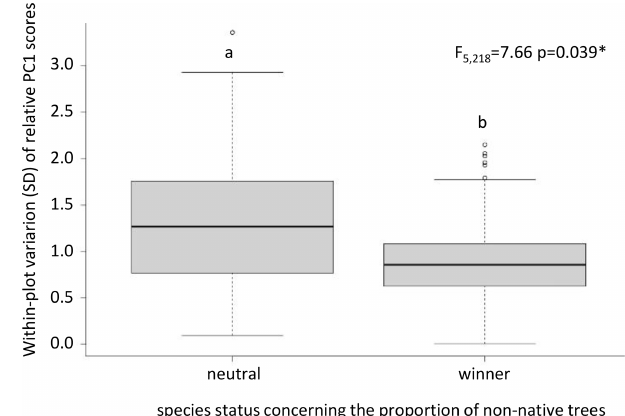
Figure 5. Differences in within-plot variation of relative morpho- logical traits by the principal component (PC1) scores of “neutral” and “winner” species respective to the proportion of non-native trees. Abbreviations: ∗ = p ≤